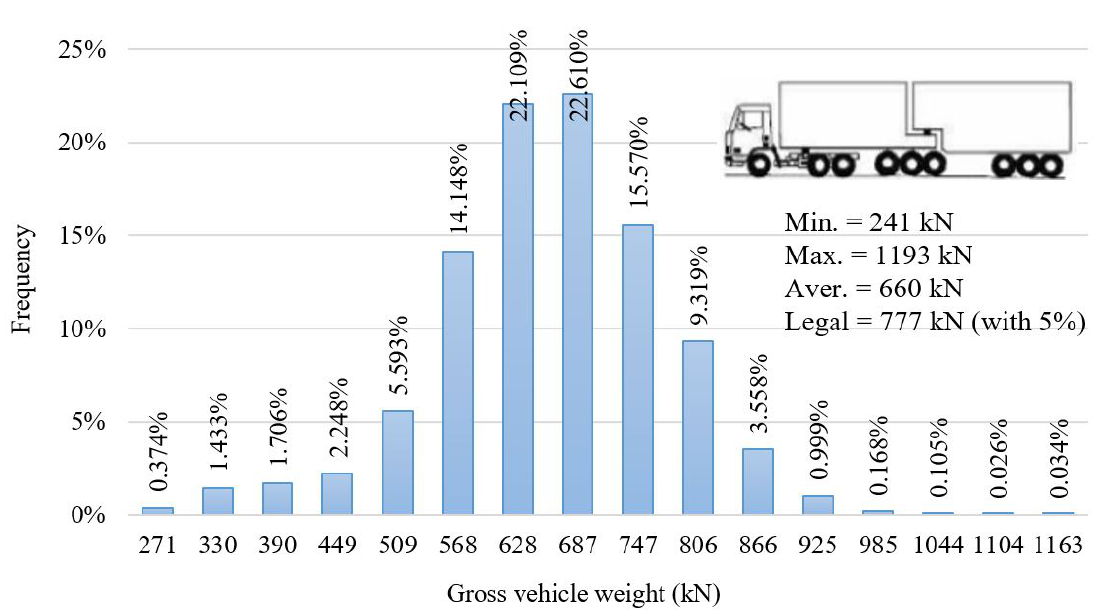
Figure 4. Histogram for GVW for class 3M6 (the horizontal axis shows the average values for each interval).